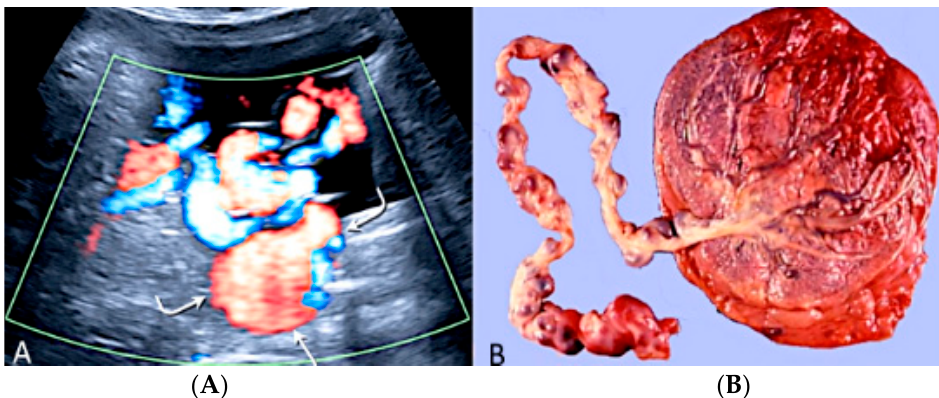
Figure 32. Doppler ultrasound ( A ) demonstrating an umbilical cord varix (curved arrows) with pathology confirmation after birth ( B ).